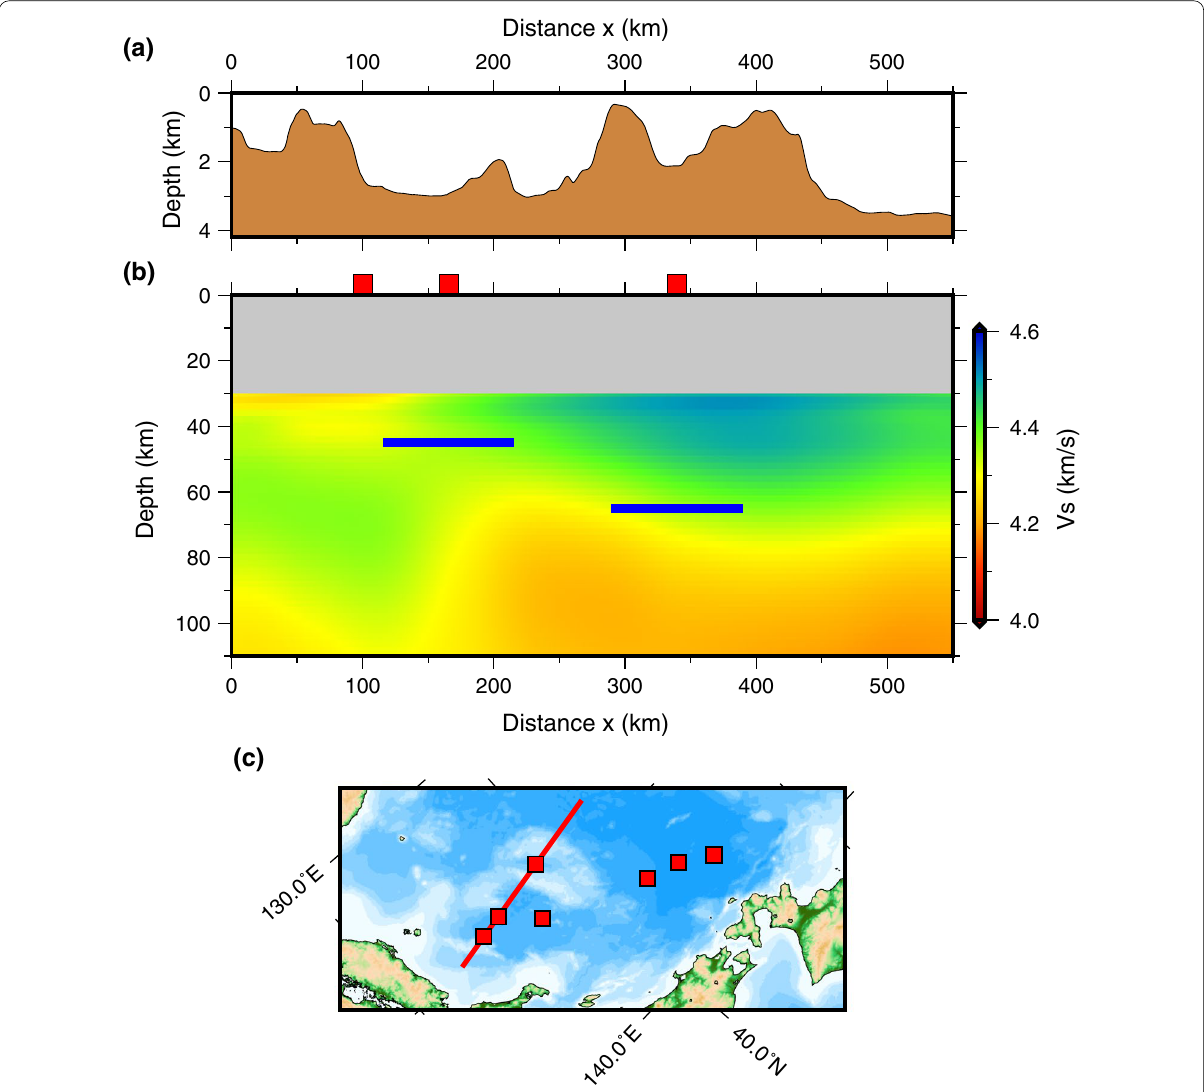
Fig. 11 Comparison to surface wave tomography model. a Seafloor topography profile. b Cross section of S-wave velocity model estimated by surface wave tomography (Yoshizawa et al. 2010). The shallow portion (< 30 km depth) is masked by the gray shade because of insufficient resolution with long-period surface waves. Blue horizons roughly indicate the lithosphere–asthenosphere boundary inferred from the inversion. Red squares denote station locations. c Profile location (red line) and station locations (red